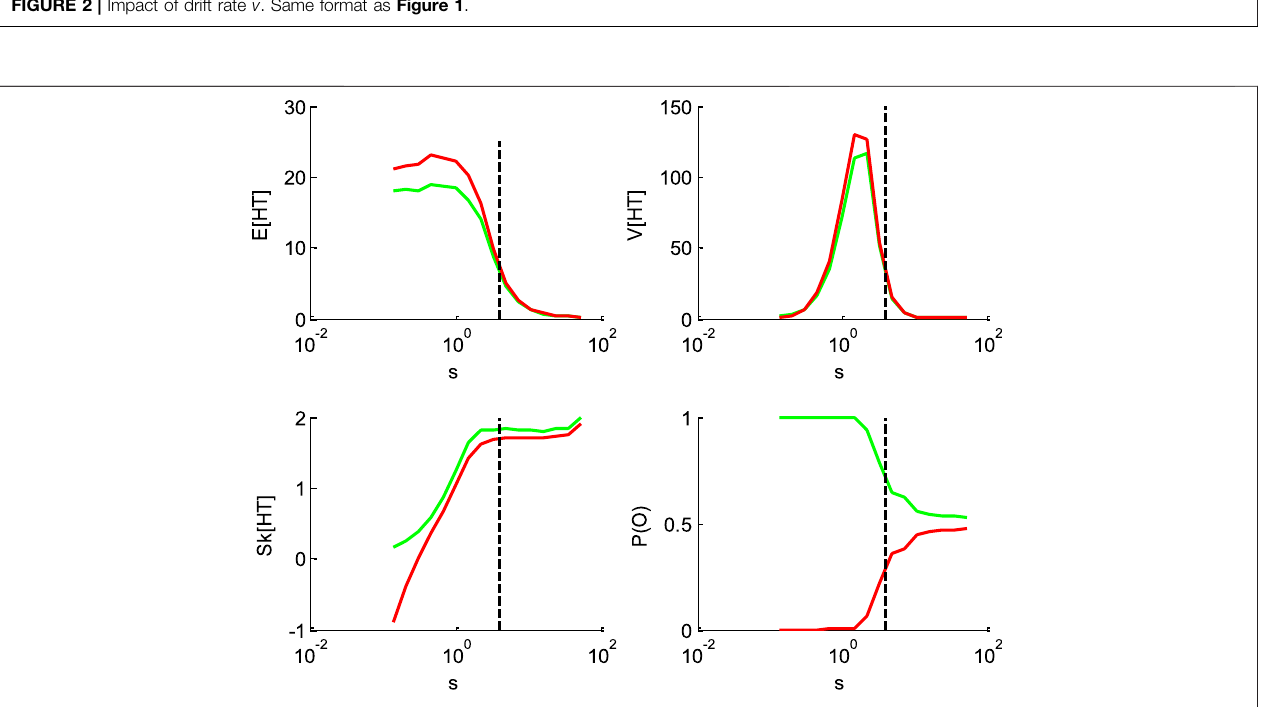
FIGURE 2 | Impact of drift rate v . Same format as Figure 1 .